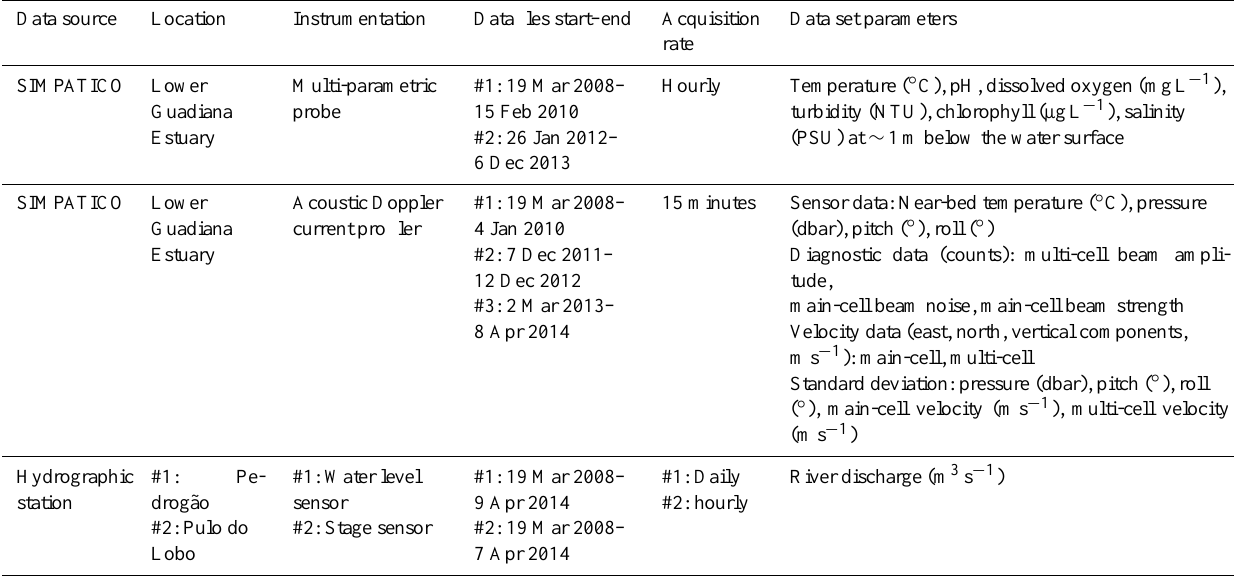
Table 1. Summary information of the data sets from the SIMPATICO monitoring station and associated river discharge